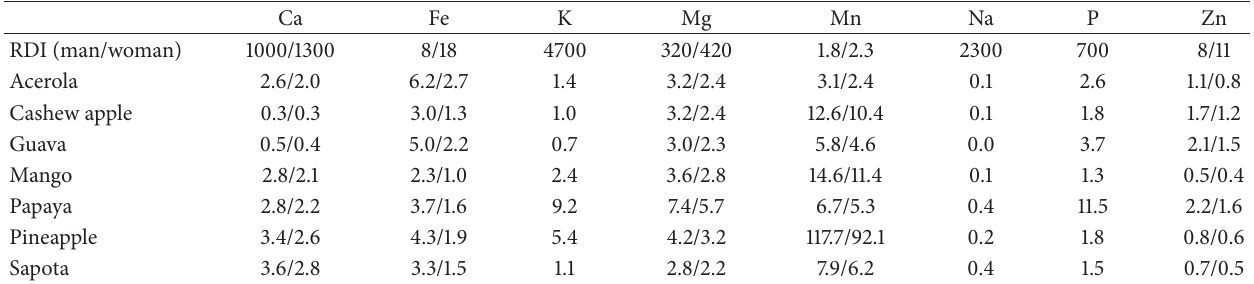
Table 6: Recommended daily intake (RDI) of minerals: the contribution (%) of a portion of 10g of each fruit residue to the recommended daily intake for man and